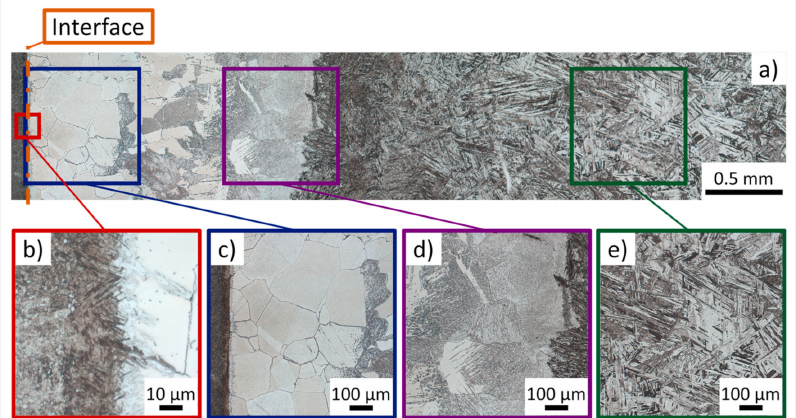
Figure 2. Optical micrographs of Kalling 2 etched samples of composite A (cold work tool steel and precipitation hardening steel): ( a ) Overview of PH steel and the interface, ( b ) Martensitic zone at the interface, ( c ) Austenitic zone with carbides at the grain boundaries, ( d ) Transition from austenite and martensite to nickel martensite, ( e ) Nickel martensite.